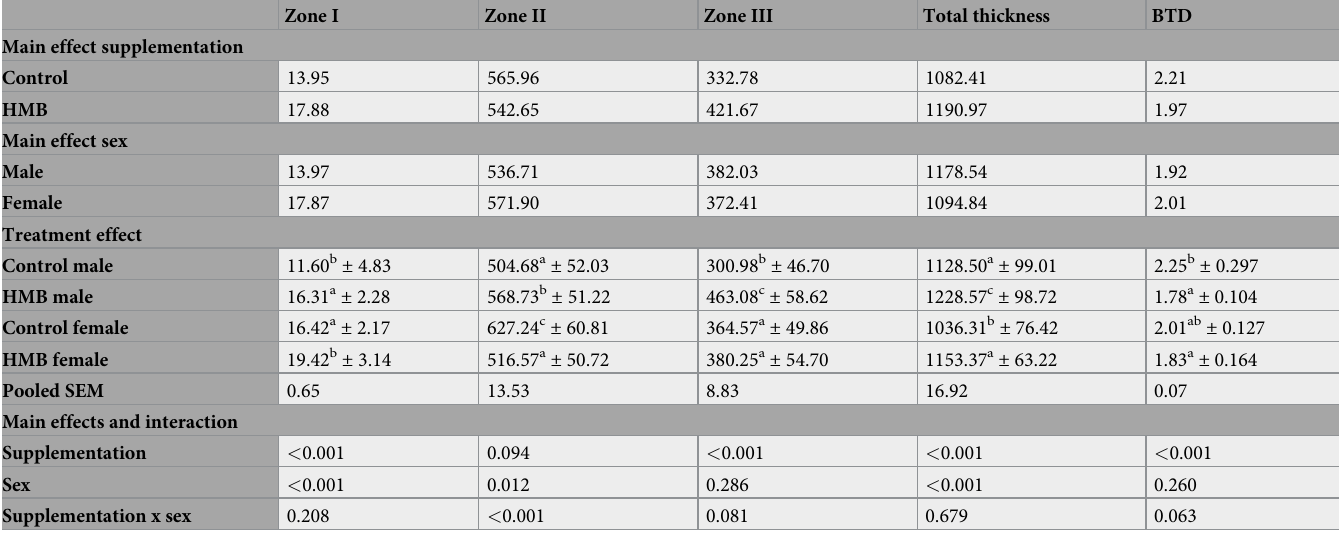
Table 6. The effect of maternal treatment with HMB on humeral articular cartilage histomorphology and BTD in newborn